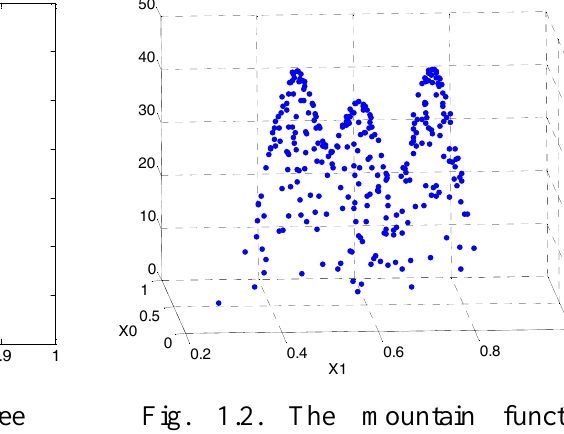
Fig. 1.2. The mountain function shows a good density shape estimate.